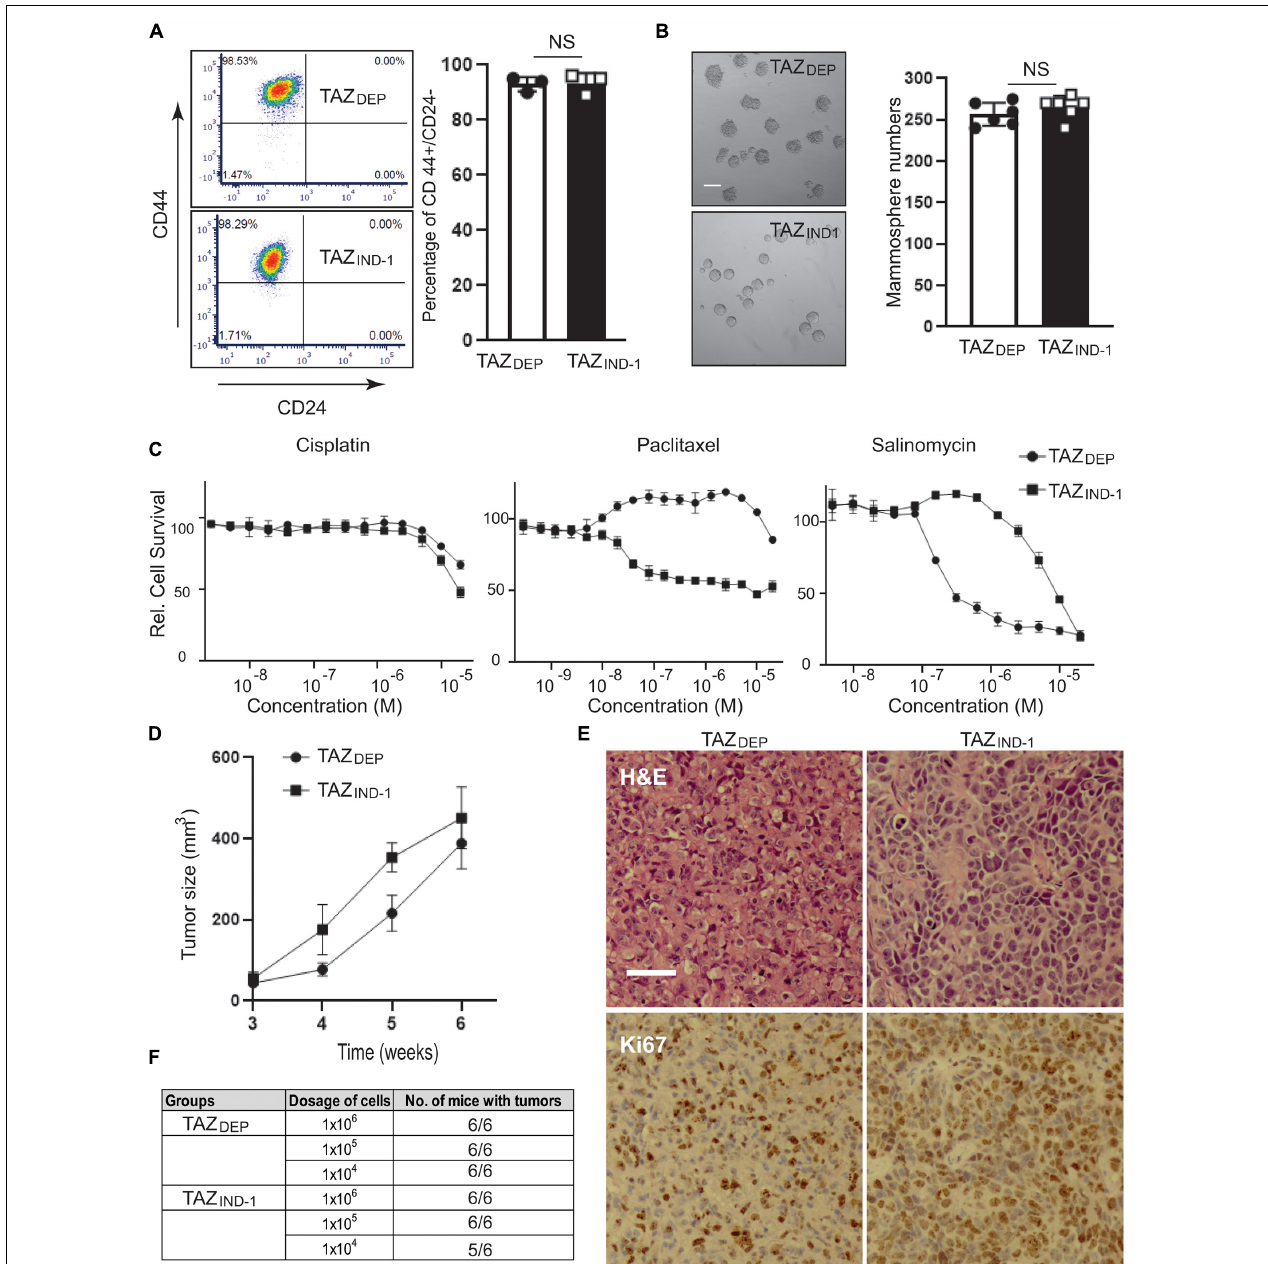
FIGURE 3 | Conservation and BCSC features and tumor formation potential. (A) Representative images and quantification of CD44 high /CD24 low cell population of TAZ DEP and TAZI ND cells by FACS analysis. Data are shown as the mean ± SD. Unpaired two-tailed Student’s t -test: NS = not significant. (B) Representative images and quantification of mammosphere formation of TAZ DEP and TAZ IND cells. Scale bar = 100 µ m. Data are shown as the mean ± SD. Unpaired two-tailed Student’s t -test: NS = not significant. (C) Cell survival was tested in response to the various concentrations of Cisplatin, Paclitaxel, and Salinomycin for TAZ DEP and TAZ IND cells. TAZ DEP cells grown in the presence of 2 µ g/ml dox. (D) 1 × 10 6 TAZ DEP or TAZ IND cells were injected into mammary gland fat pads of SCID mice ( n = 6). TAZ DEP cells injected into mice were fed with dox-containing chow (Bio-serv, NJ). Tumor growth rates were measured weekly by caliper. (E) H&E and Ki67 immunohistochemical (IHC) staining for TAZ DEP -or TAZ IND tumors. Scale bar = 50 µ m. (F) Serial diluted (1 × 10 6 , 1 × 10 5 , 1 × 10 4 ) TAZ DEP or TAZ IND cells were injected into the mammary fat pads of SCID mice ( n = 6). Tumor formation capability was